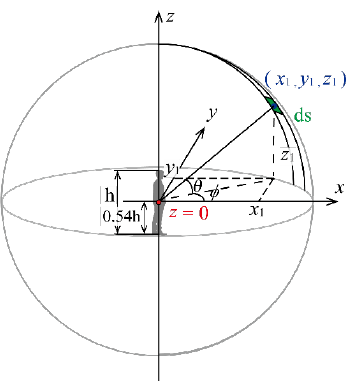
Figure 5. View factor from the point to the human body.